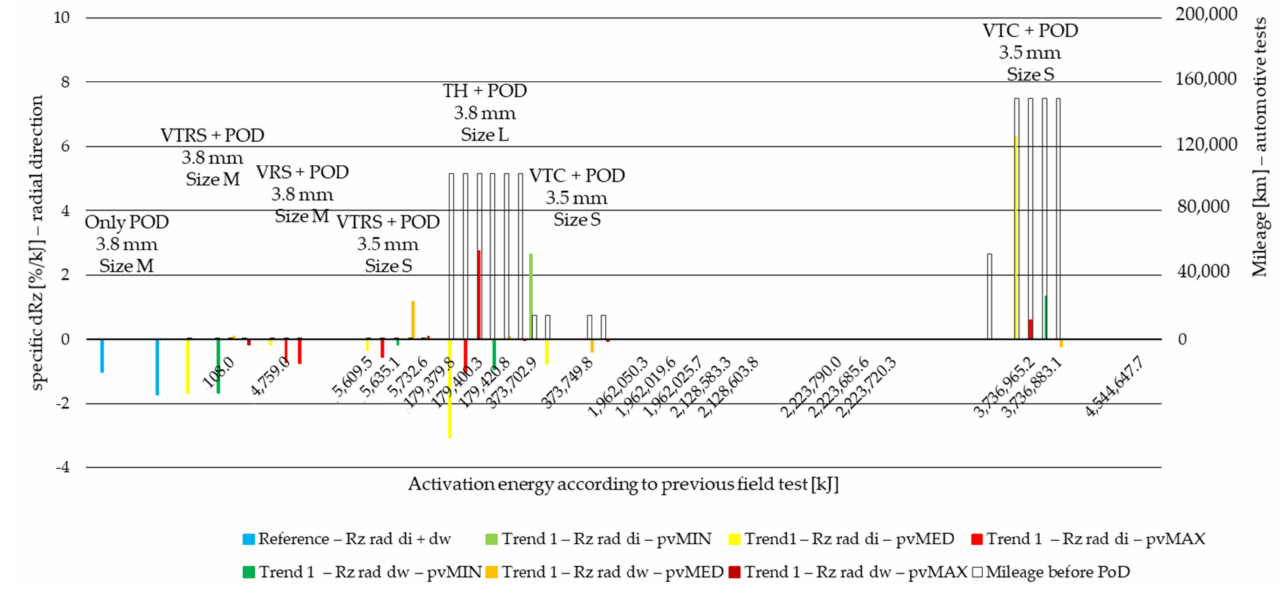
Figure A1. Radial direction PoD specific Rz difference values of cut material samples from inner and working diameter after minimum, medium and maximum pv level pin-on-disc tests with previous field-test (Table 2) mileage along Joule scale—Trend 1: clutch killer load